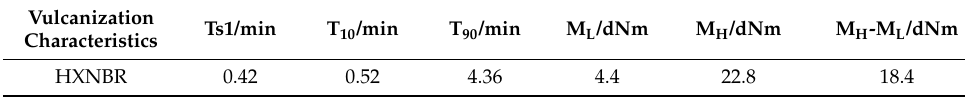
Table 1. Vulcanization properties of the HXNBR